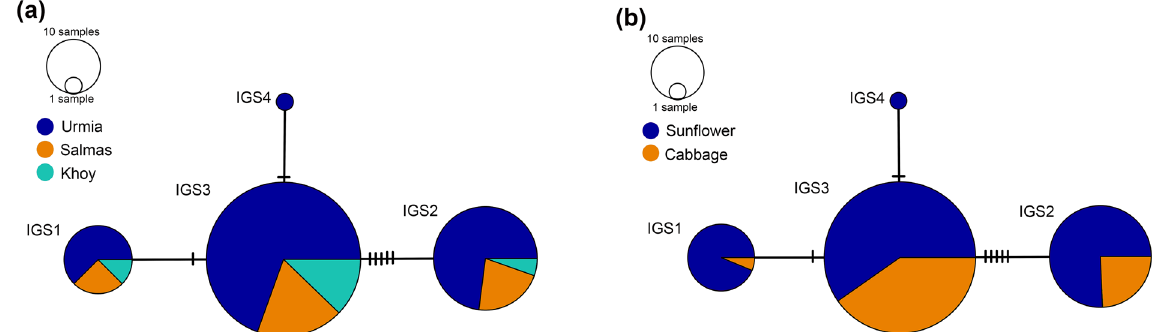
Figure 5. Median-joining networks displaying the relationships between IGS haplotypes of Sclerotinia sclerotiorum from West Azarbaijan province of Iran and their distribution in geographic ( a ) and host ( b ) populations. Each circle indicates a single haplotype and the size of circle corresponds to the frequency of that haplotype. Each hatch mark on the lines joining haplotypes, represents one nucleotide